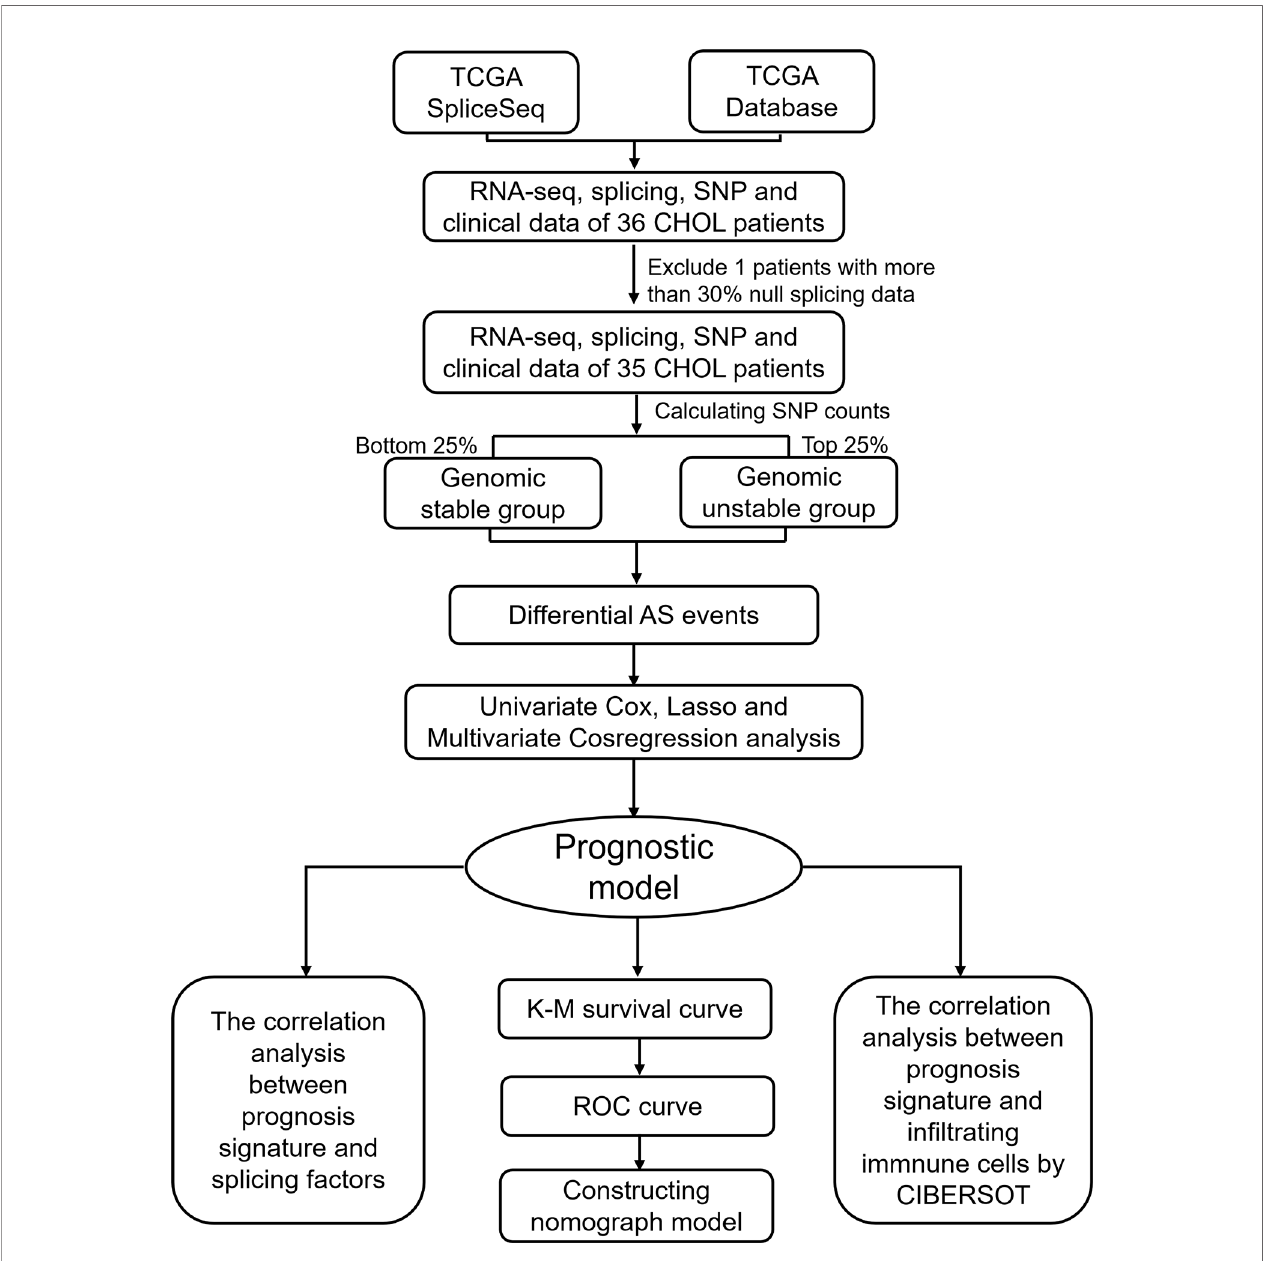
FIGURE 1 | Flow diagram of the approach used in this